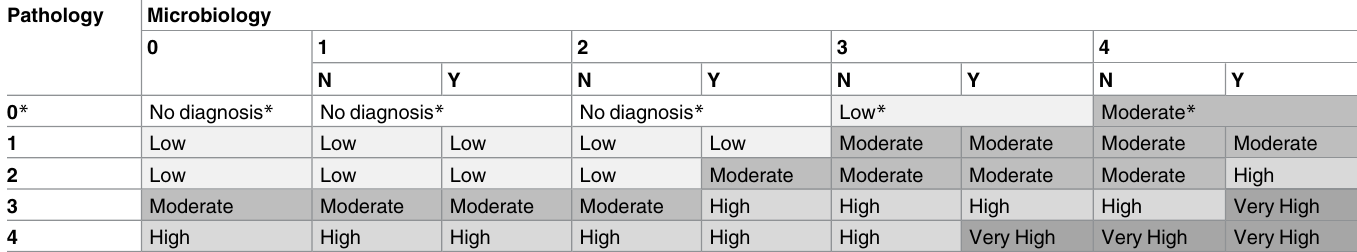
Table 2. Level of certainty of the diagnosis of cause of death obtained by combination of the strength of the evidence of the pathological and microbiological findings.